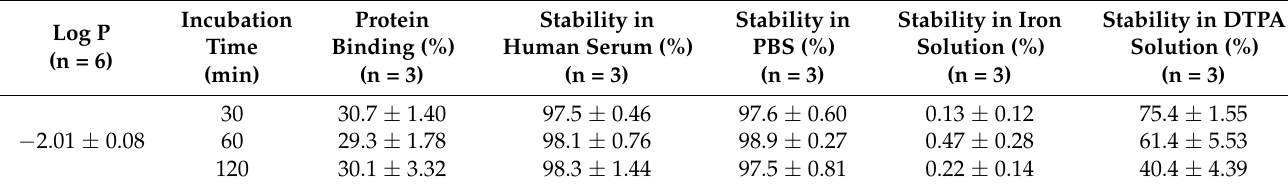
Table 1. In vitro characterization of [ 68 Ga]Ga-DFO-c(RGDyK). Log P, protein binding (expressed as % of protein bound activity of the total activity used) and stability in human serum, PBS, 0.1 M FeCl 3 , and 6 mM DTPA.